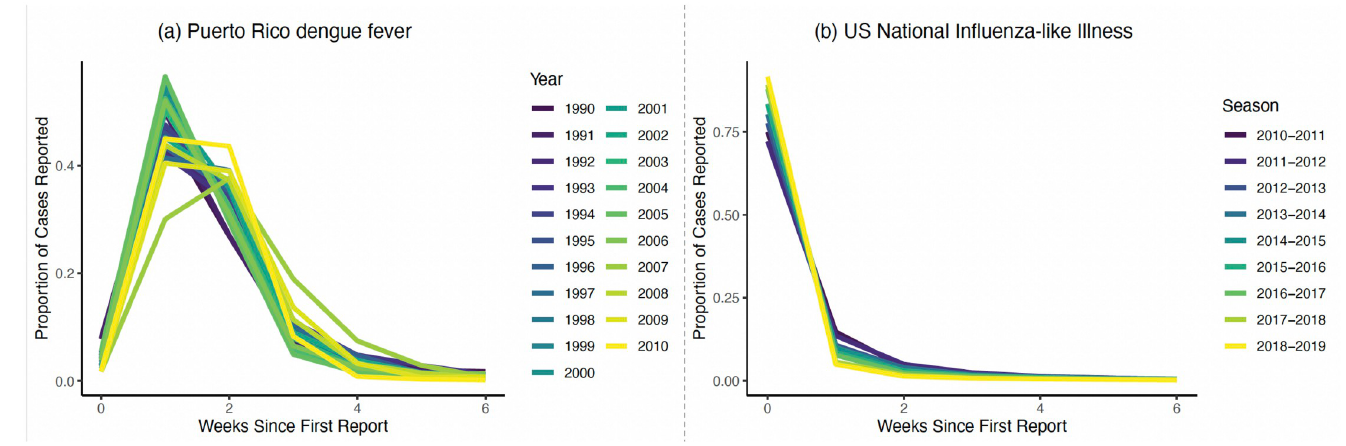
Fig 1. Proportion of eventually-reported cases that were reported in each week 1 . 1 Estimates of π ts ( d ) − π ts ( d − 1), obtained using Eq 6 and stratified by season/year.